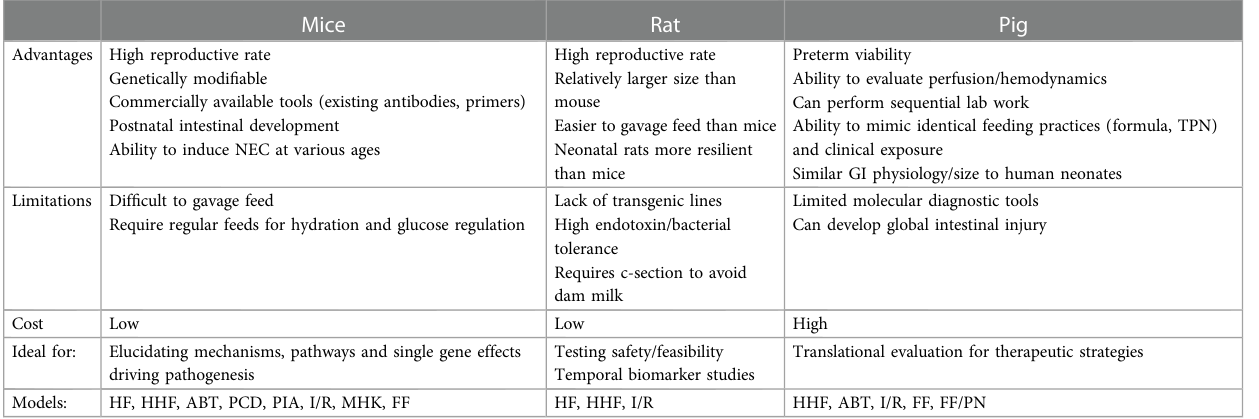
TABLE 3 Animal models of NEC- advantages and limitations. Mice Rat